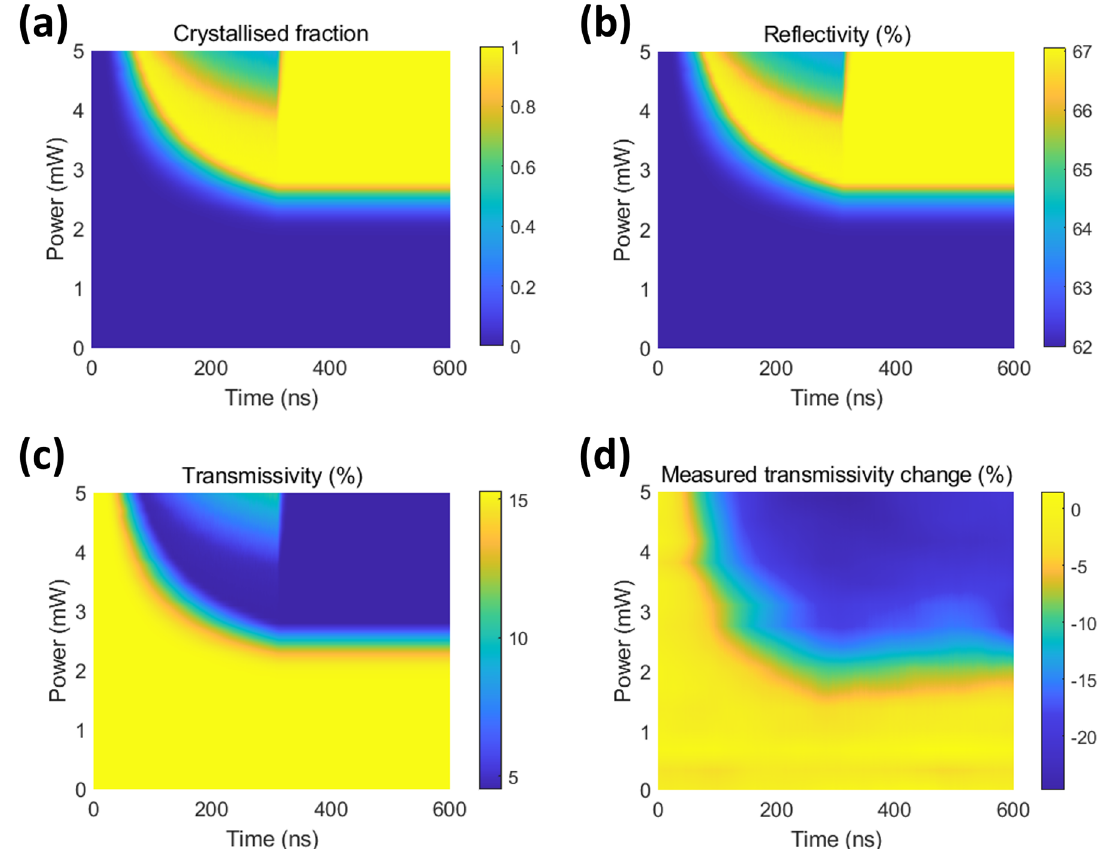
Fig. 3 Transient evolution of crystallisation. Simulated evolution of a crystallised fraction, b re fl ectivity and c transmissivity at different laser power. d Evolution of measured relative transmissivity change during